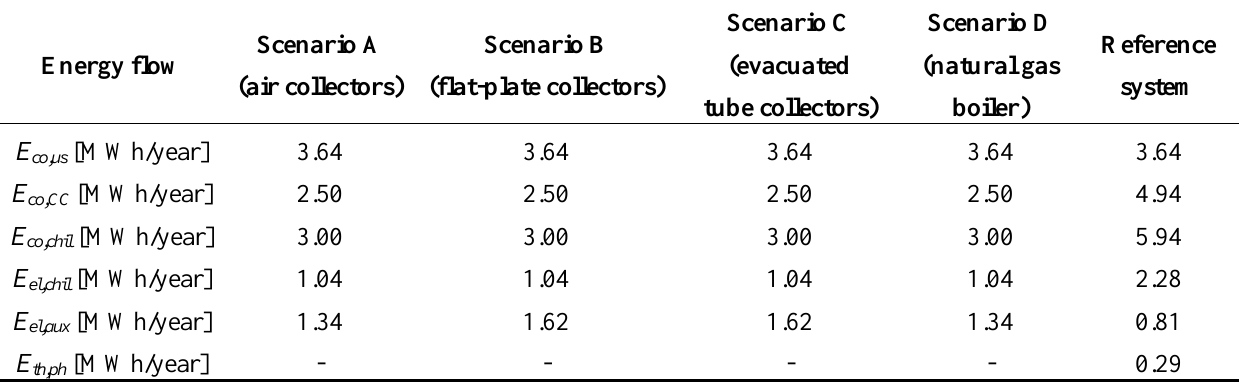
Table 3. Main energy flows of the investigated